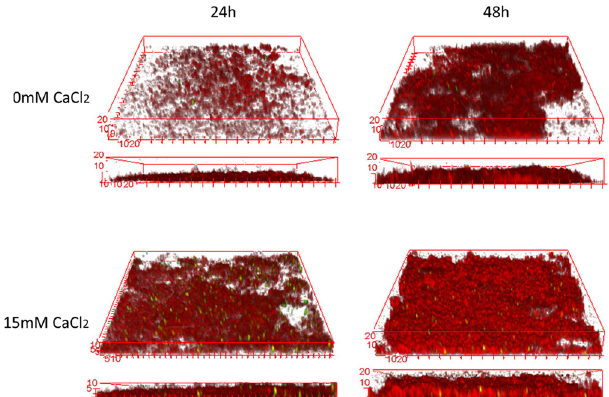
Fig. 1. Three dimensional (xyz) and corresponding two dimensional (xz) CLSM projections of 24 h and 48 h mCherry-expressing Pseudomonas fl uorescens following growth in the absence (0 mM) or presence (15 mM) of CaCl 2 . The green dots are fl uorescent